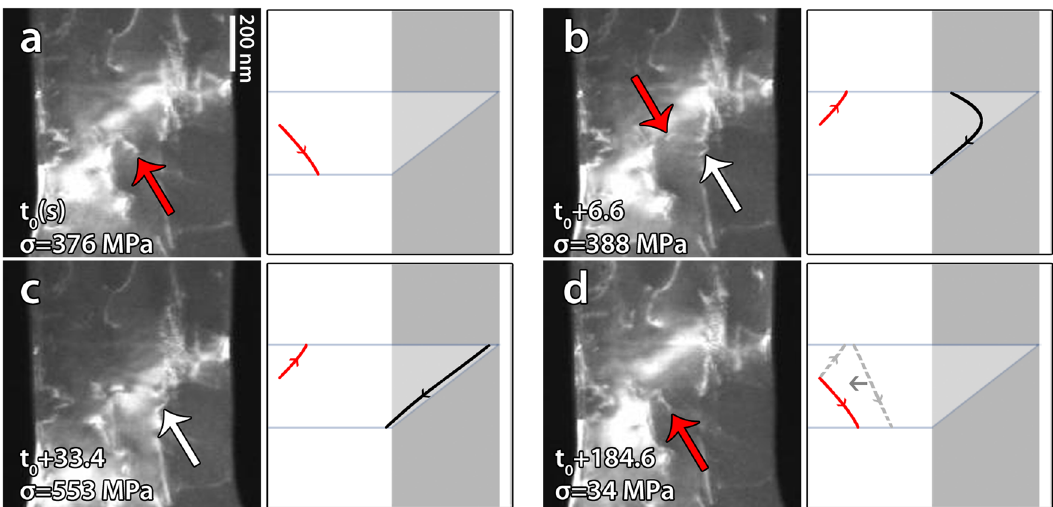
Fig. 5 Interaction between CTB and non-screw dislocations. a – c Snapshots from Supplementary movie 3 of cycle 3 showing the microstructure and the corresponding schematics observed during the interaction between non-screw dislocation from the single arm source SAS3 and the CTB at different times. Red (resp. white) arrows indicate the position of the source (resp. the incoming dislocation). Note the re fl ection of the dislocation at the CTB followed by the annihilation of a segment of the same dislocation with the source leading to the fi nal con fi guration shown in ( d